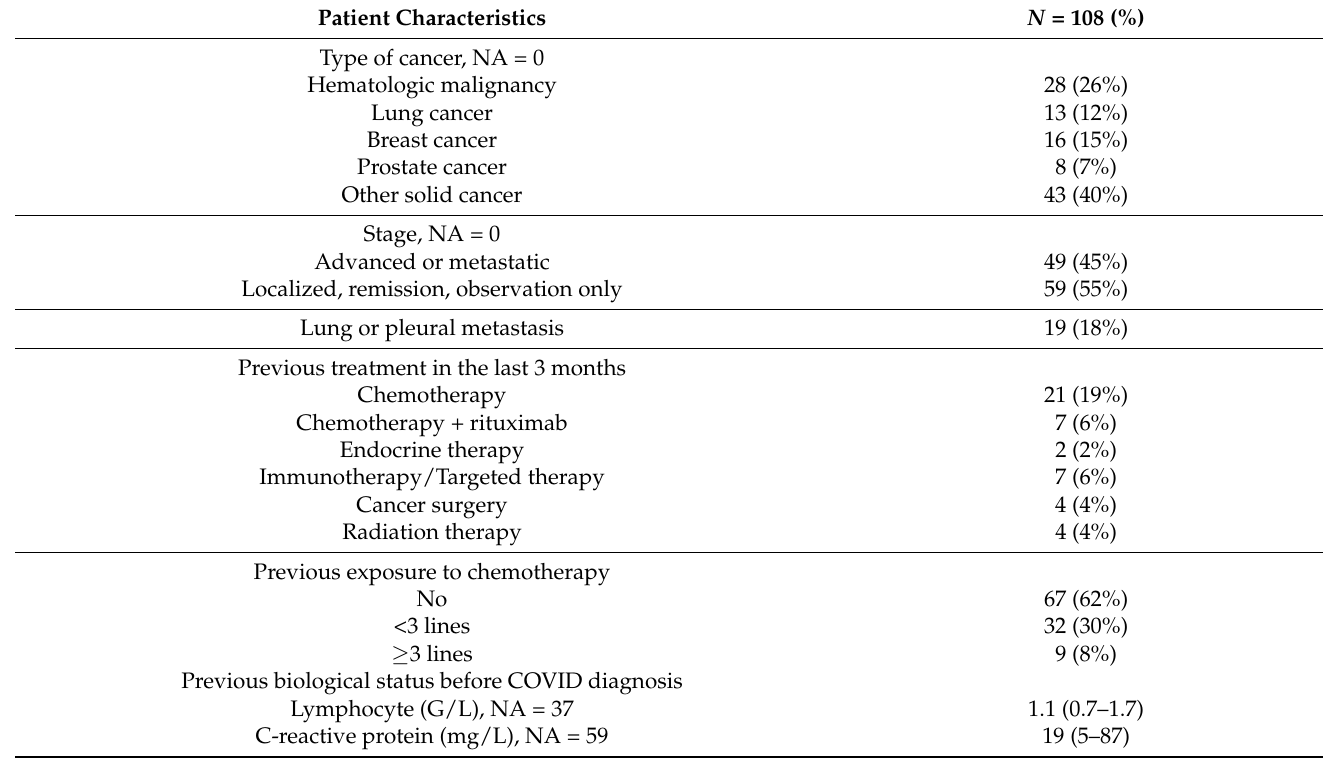
Table 2. Description of the cancer characteristics in the cancer cohort.